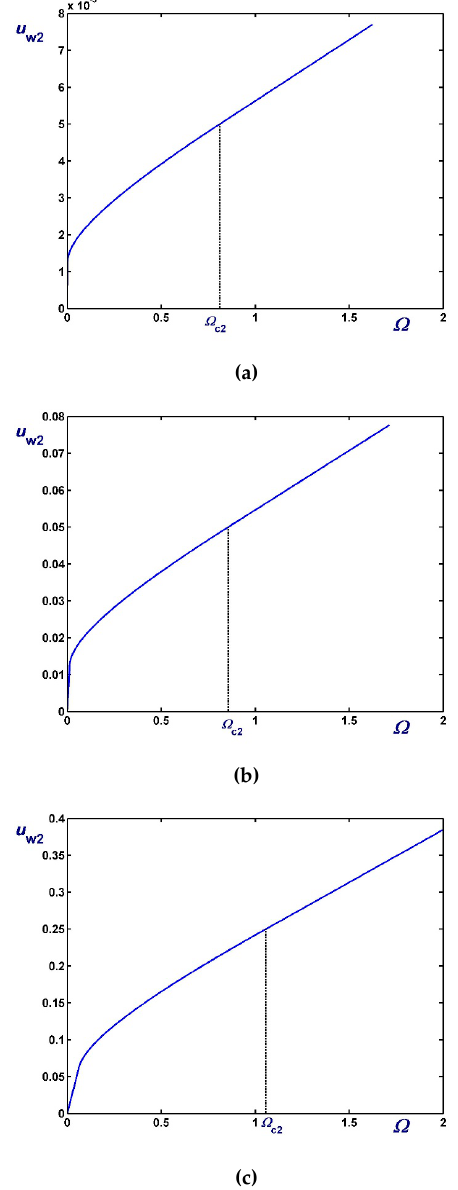
Figure 3. Outer wall slip velocity for κ = 0.5, B 1 = 0 (no slip along the rotating inner cylinder) and Navier slip along the fixed outer cylinder: ( a ) B 2 = 0.01 (weak slip); ( b ) B 2 = 0.1 (moderate slip); ( c ) B 2 = 0.5 (strong